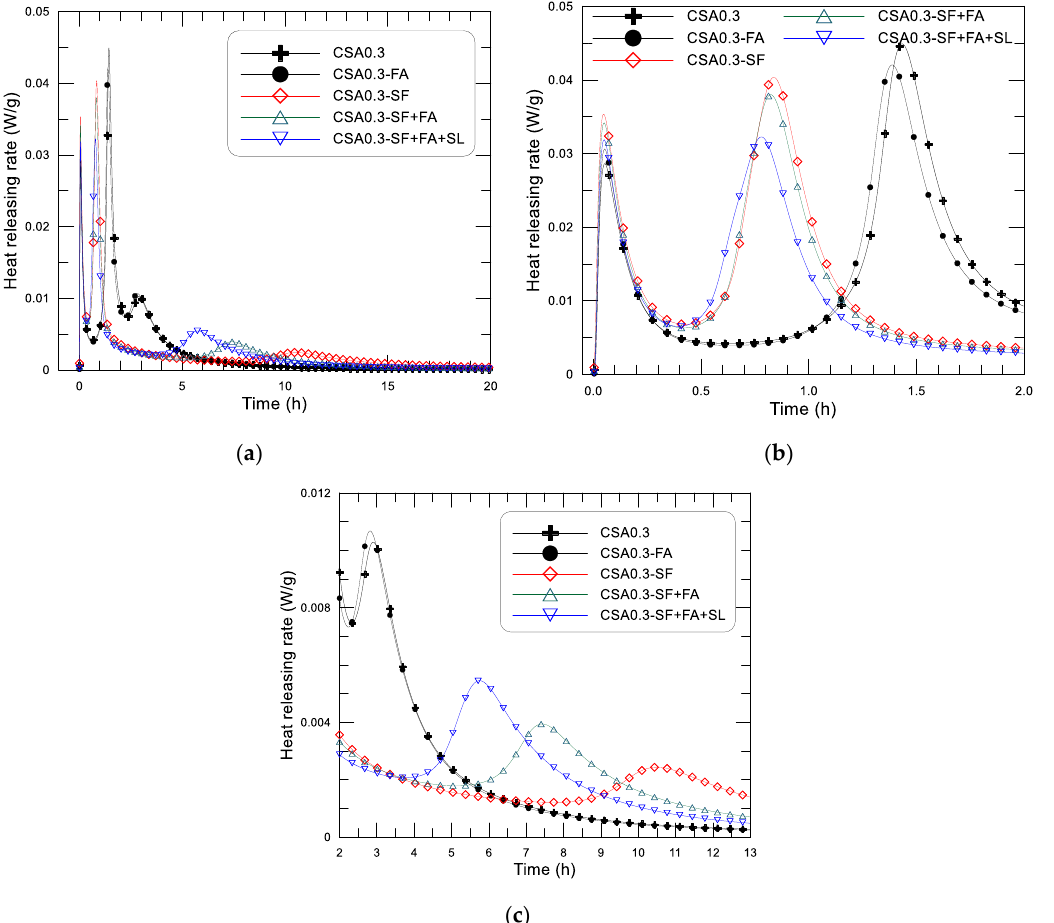
Figure 7. Heat-releasing rate of CSA pastes with different addition of SCMs: ( a ) results of 20 h, ( b ) results of the initial 2 h, ( c ) results of 2–13 h.